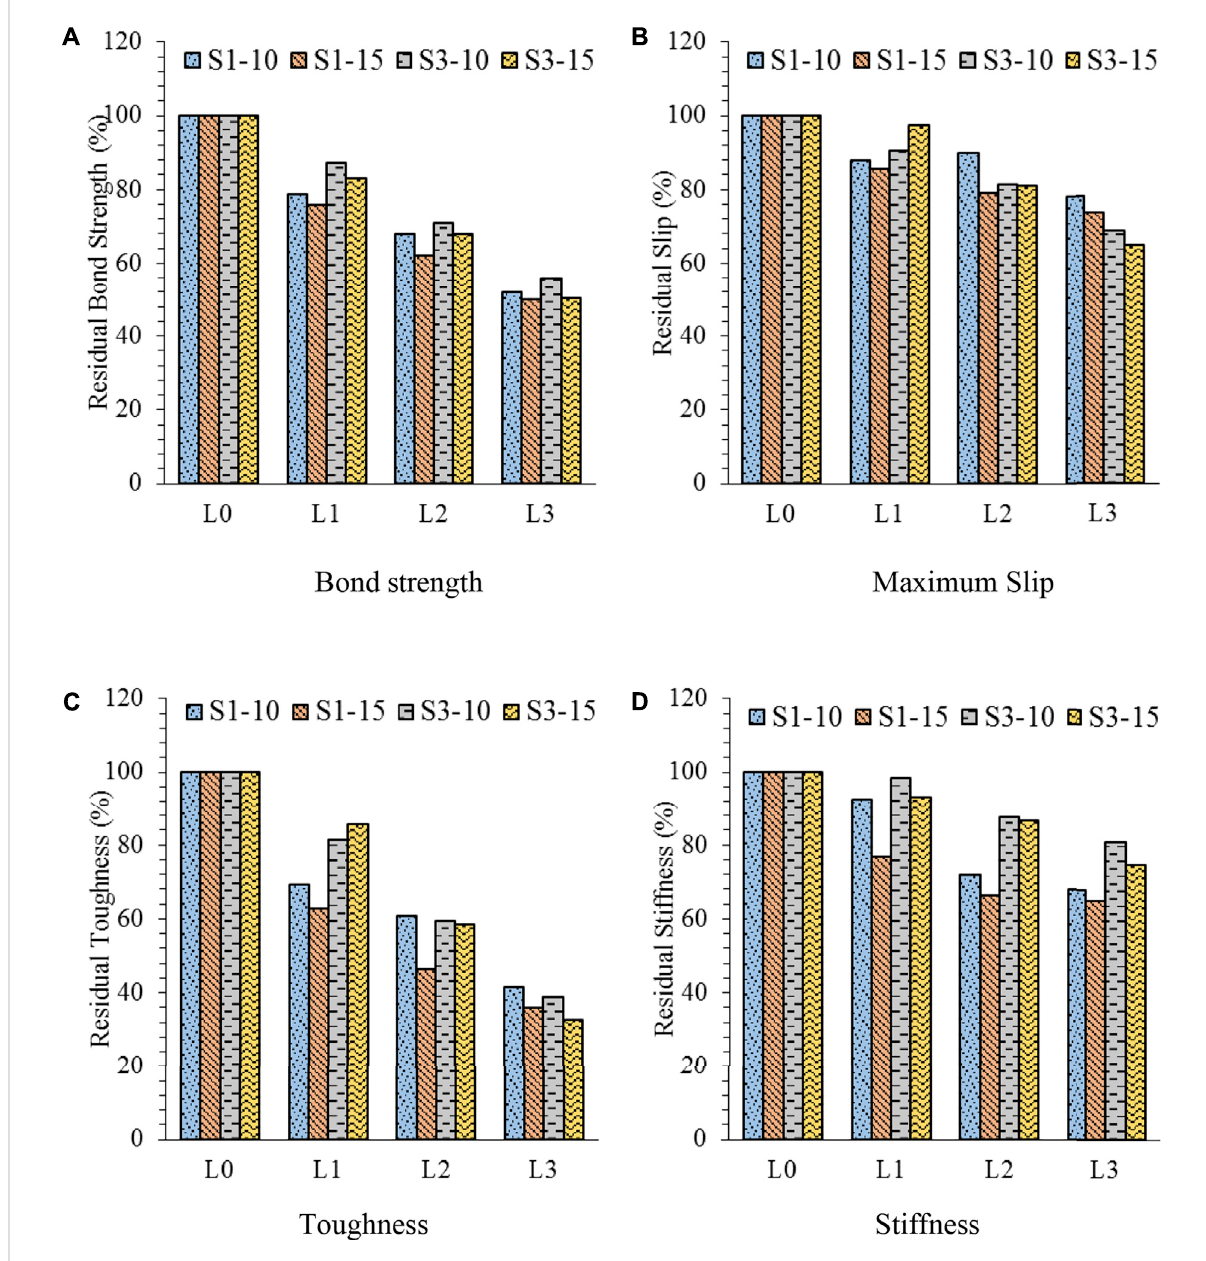
FIGURE 13 Residual bond characteristics for different corrosion levels. (A) Bond strength. (B) Maximum Slip. (C) Toughness. (D) Stiffness.